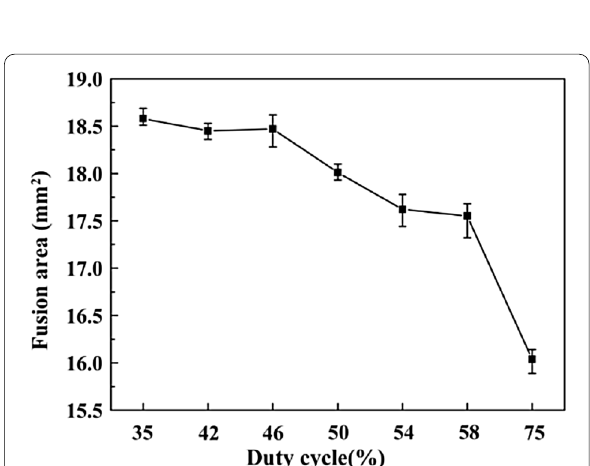
Figure 28 Fusion area of the combined surface of the welded joint under different duty